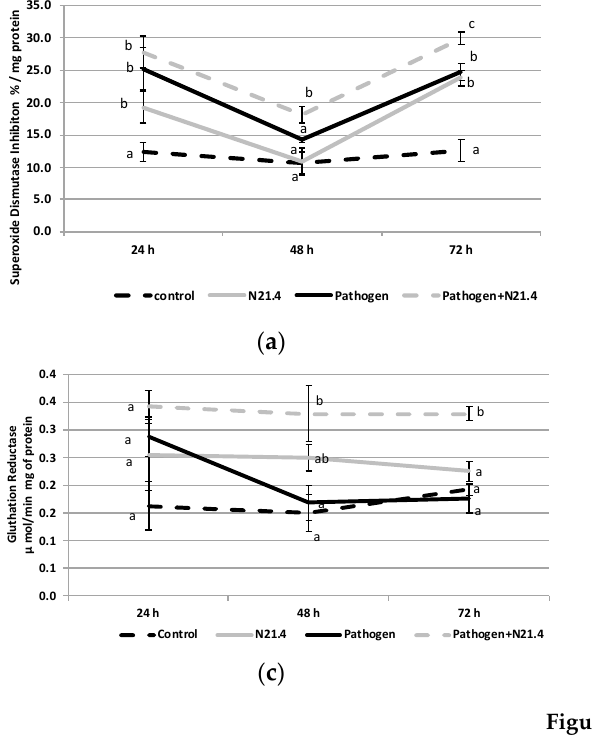
Pathogen + N21.4: plants treated with Pseudomonas fluorescens N21.4 and challenged with the leaf spot pathogen Xanthomonas campestris. Bars indicate standard errors ( n = 3). Different letters denote